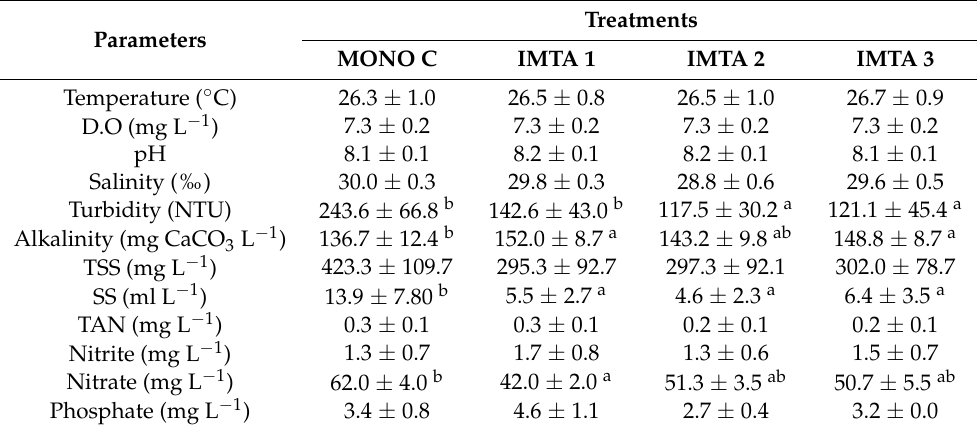
Table 6. Water quality parameters (mean ± standard deviation) of treatments: the MONO C (with no Ulva), IMTA 1 (with 1 g Ulva L − 1 ), IMTA 2 (2 g Ulva L − 1 ), and IMTA 3 (3 g Ulva L − 1 ) treatment groups during the 35 days of the experiment.